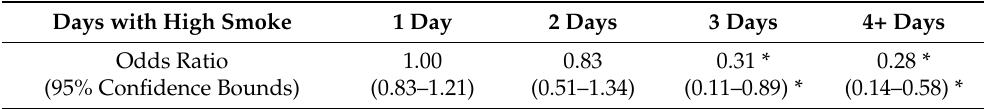
Table 3. Estimated odds of at least one asthma emergency room visit in fire smoke days relative to odds on days with no smoke exposure in the previous